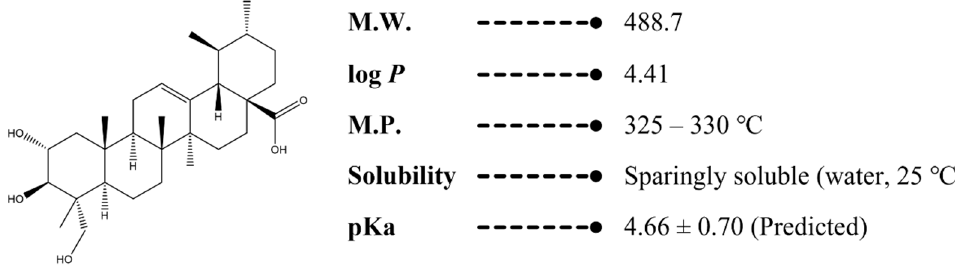
Figure 1. The structure and properties of AA.